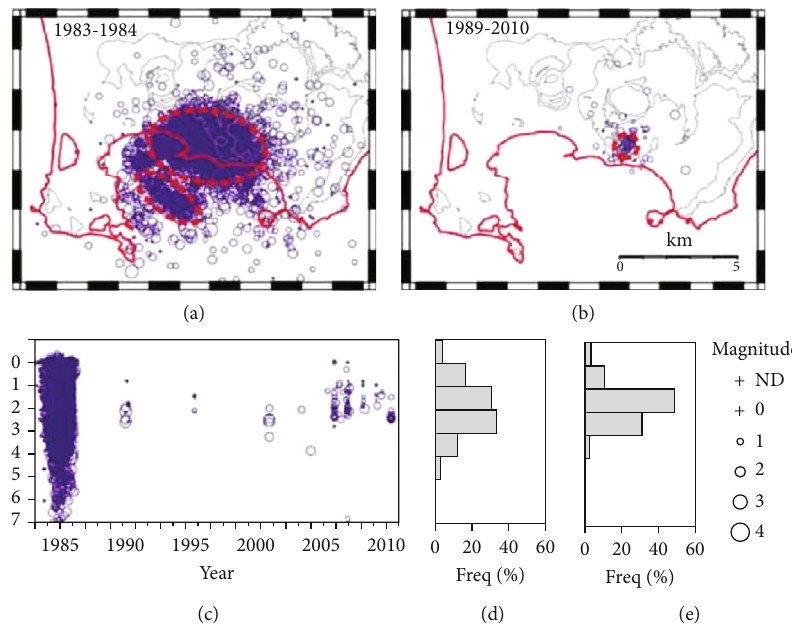
Figure 3: (a) Blue circles indicate epicenters of earthquakes recorded between 1983 and 1984; the dashed red ellipses mark the two main clusters. (b) The same for the period 1989 – 2010, the dashed red circle marks the cluster. (c) Hypocenter depths as a function of time. (d) Percentage of hypocenters for each depth range for the period 1982 – 1984 (the depth scale is the same as for (c)). (e) The same for the period 1989 – 2010 (from D ’ Auria et al. [6]).